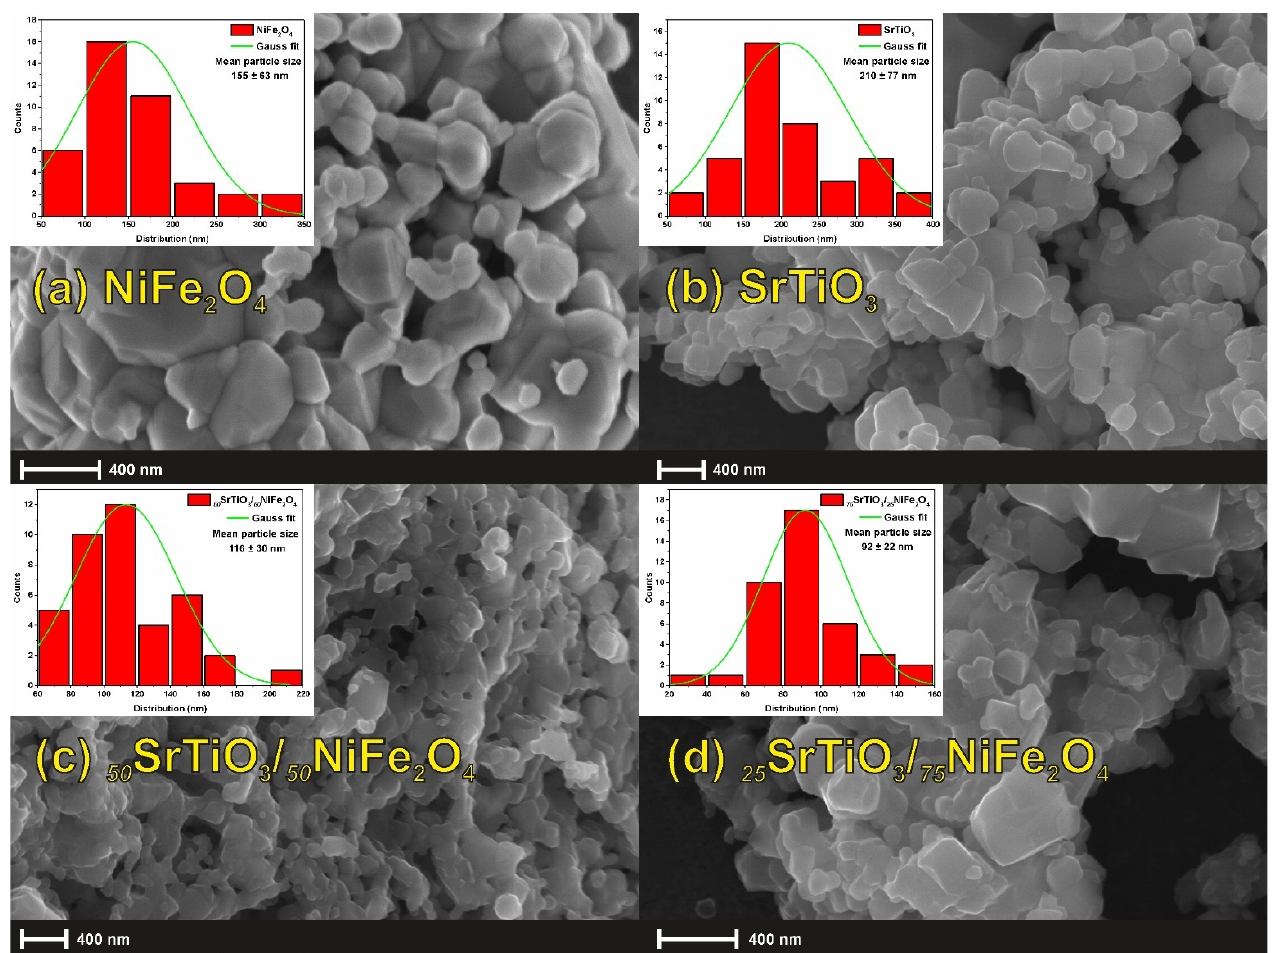
Figure 3. FE-SEM images of ( a ) pristine NiFe 2 O 4 [scale 400 nm, electron high tension EHT = 50 KV and MAG = 35 kX], ( b ) pristine SrTiO 3 [scale 400 nm, electron high tension EHT = 20 KV and MAG = 20 kX], ( c ) 50 STO/ 50 NFO [scale 400 nm, electron high tension EHT = 20 KV and MAG = 25 kX], and ( d ) 25 STO/ 75 NFO [scale 400 nm, electron high tension EHT = 20 KV and MAG = 35 kX] composites. Histograms (inserted) showing the particle size distribution of the starting materials and the two composites by using the ImageJ software. The mean value of the particle size and the errors (standard deviation (SD) were calculated by a Gaussian distribution applied to the histograms obtained.